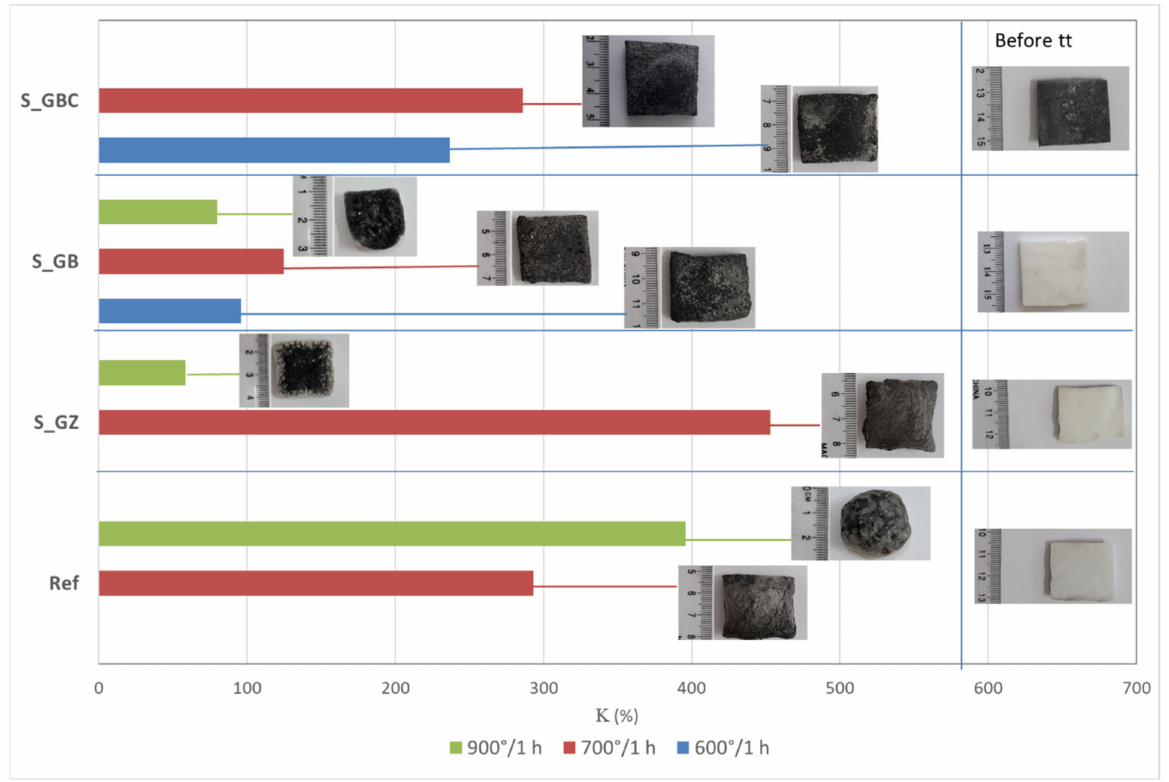
Figure 4. Visual aspect and intumescence coefficient (K) after 60 min of thermal treatment (tt) at different